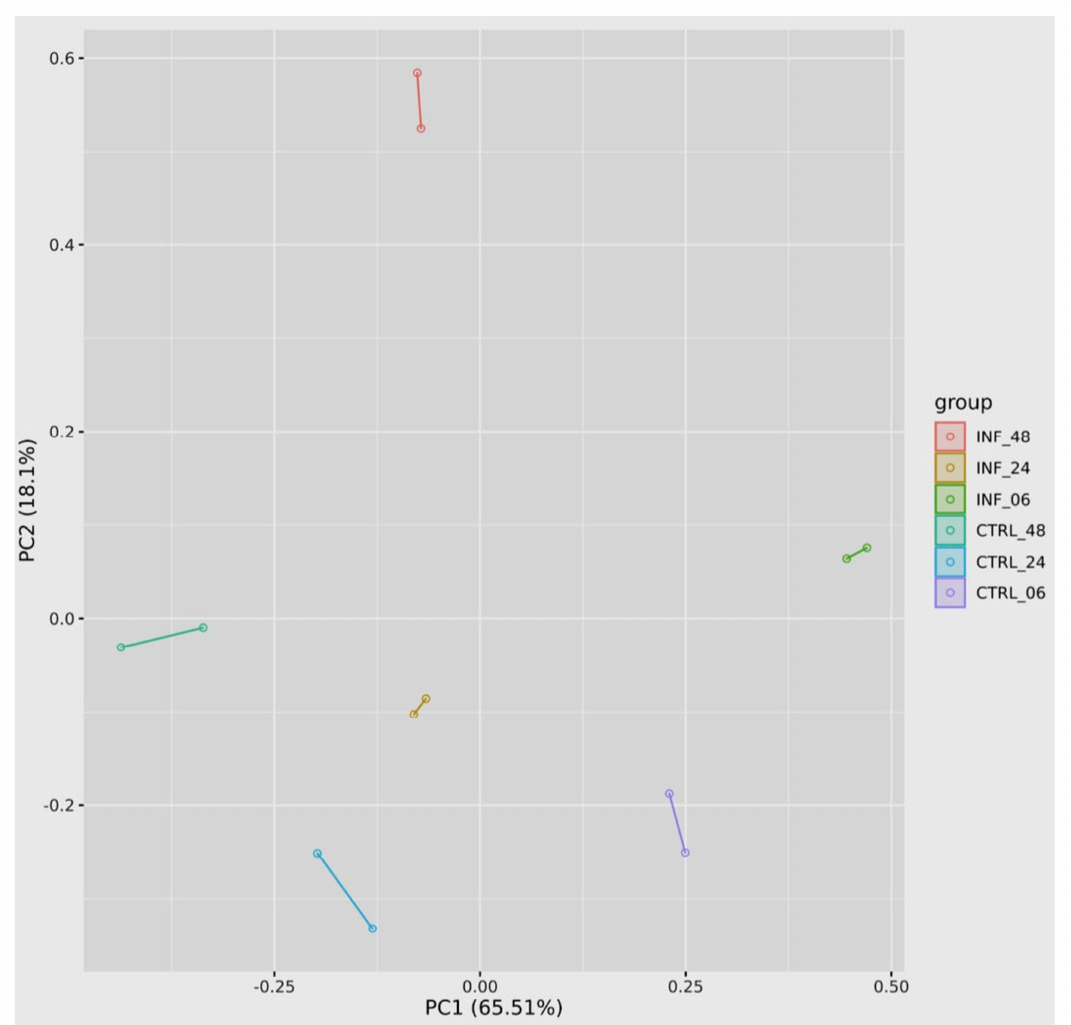
Figure 6. Principal Component Analysis of RNA-seq-based differential gene expression between infected and control hBMECs at 6-, 24- and 48-hpi. Two biological replicates are shown for each time